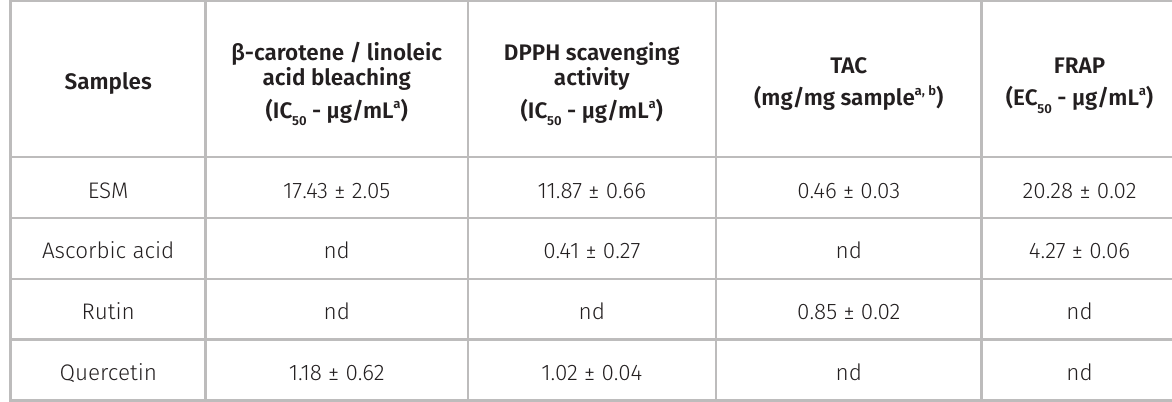
nd, not determined. a Values expressed by mean ± S.D. b TAC means total antioxidant capacity expressed as mg of ascorbic acid equivalent to mg of